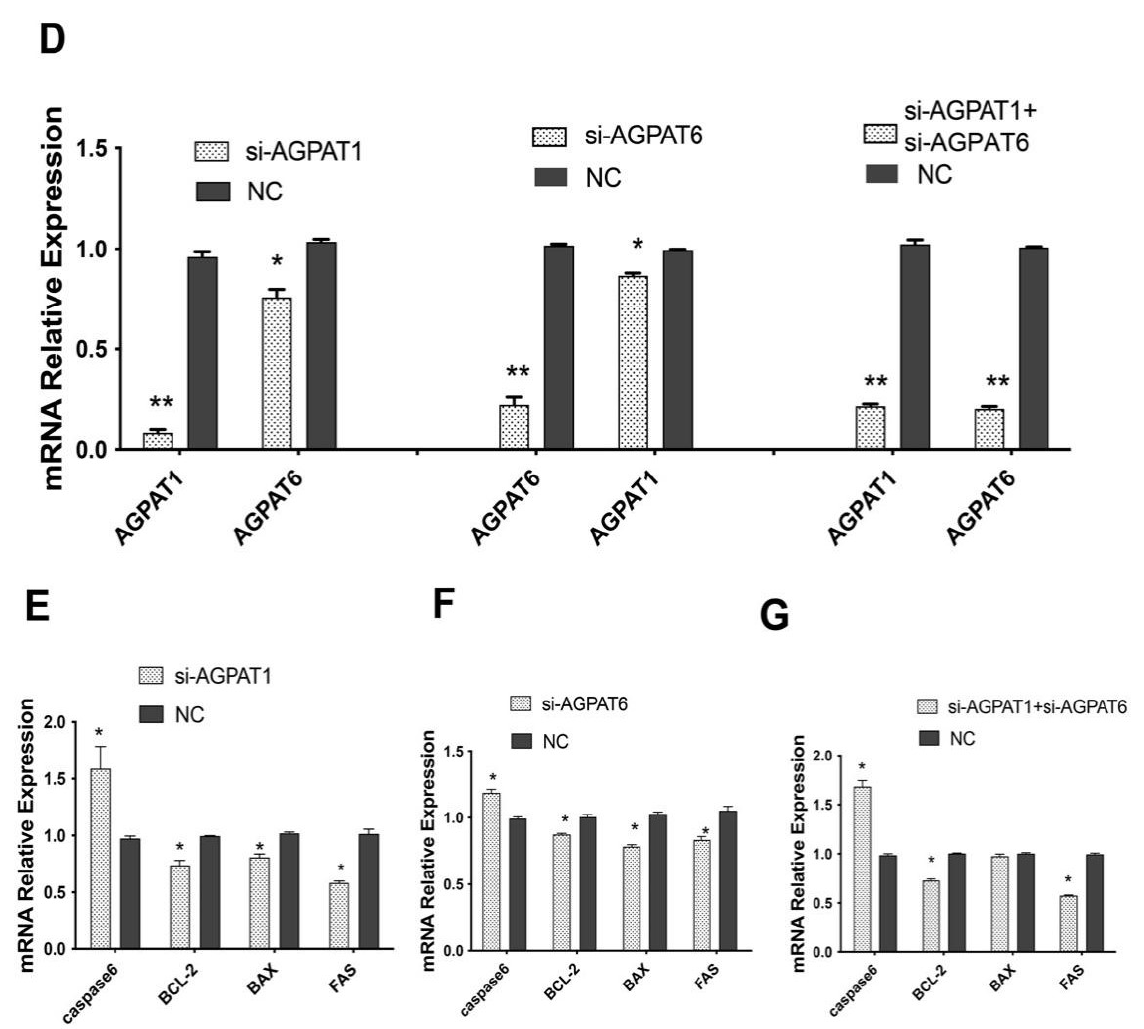
Figure 5. AGPAT1 and AGPAT6 promote cell apoptosis of BuMECs. ( A ) Apoptosis rates detection of AGPAT1 knockdown in BuMECs; ( B ) Apoptosis rates detection of AGPAT6 knockdown in BuMECs; ( C ) Apoptosis rates detection of both AGPAT1 and AGPAT6 knockdown in BuMECs; ( D ) The expression levels of AGPAT1 and AGPAT6 after AGPAT1 or/and AGPAT6 silencing at 48 h; ( E ) Effect of AGPAT1 knockdown on apoptosis-related genes expression; ( F ) effect of AGPAT6 knock- down on apoptosis-related genes expression; ( G ) Effect of both AGPA1 and AGPAT6 knockdown on apoptosis-related genes expression. * p < 0.05; ** p < 0.01. si-AGPAT1 represents the siRNA inter- ference for AGPAT1 ; si-AGPAT6 represents the siRNA interference for AGPAT6 ; NC indicates the control group.